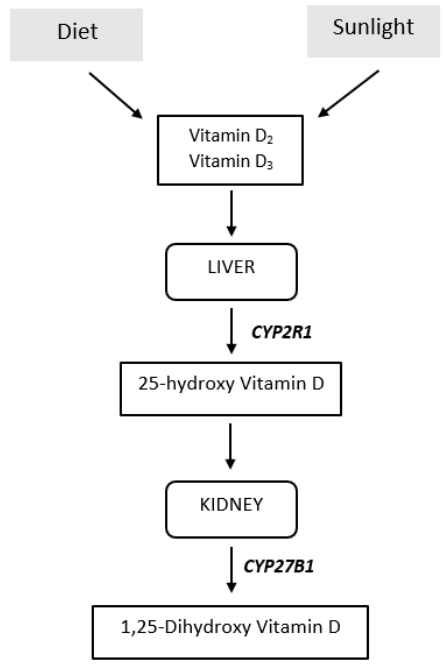
Figure 1. Metabolism of vitamin D.